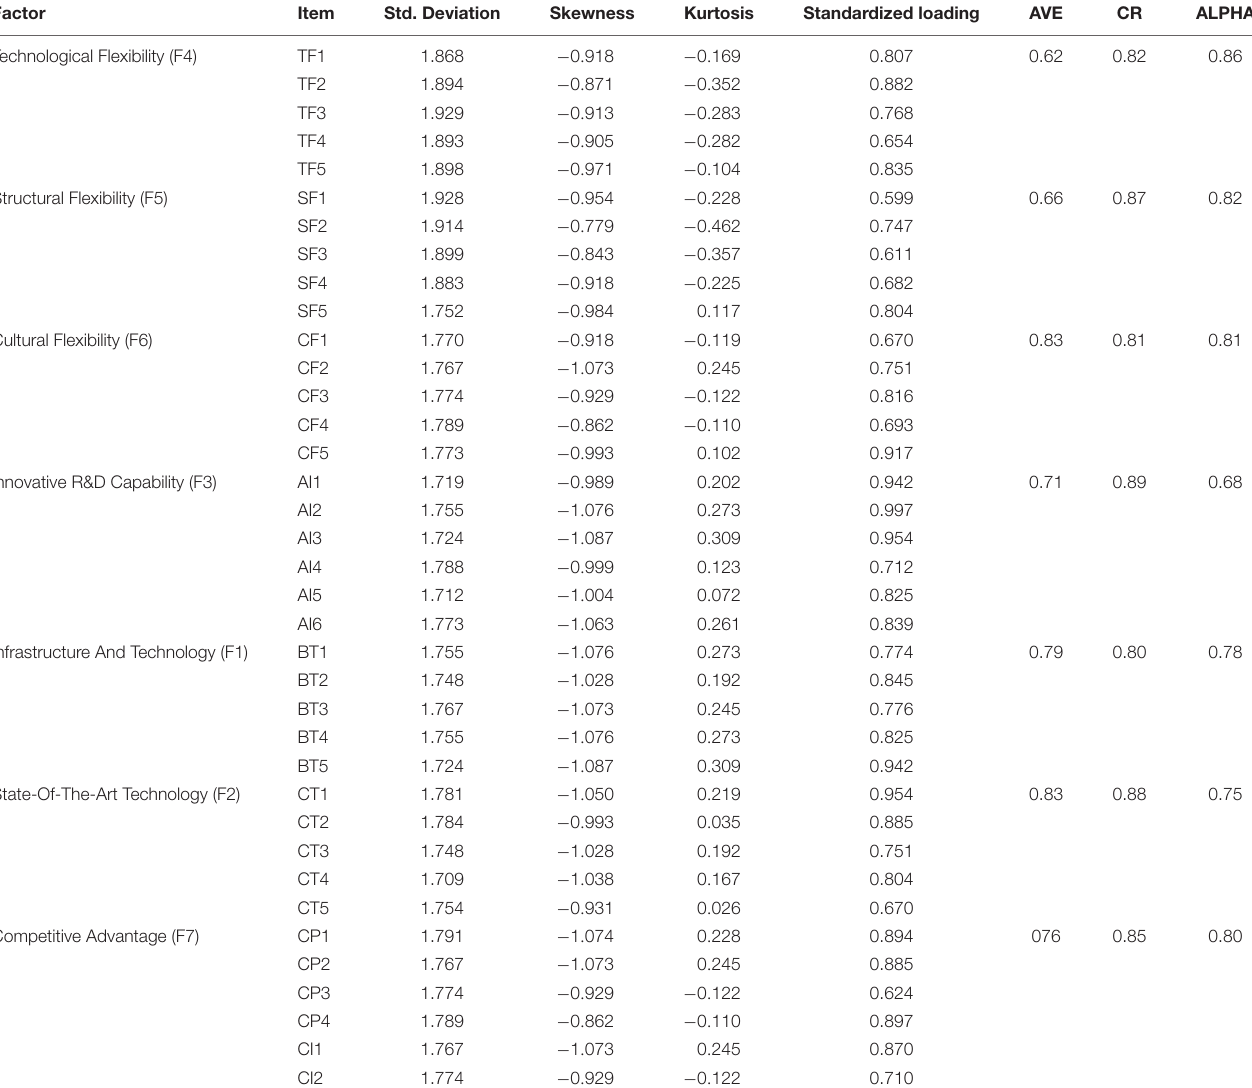
TABLE 1 | Standardized item loadings, AVE, CR, and alpha